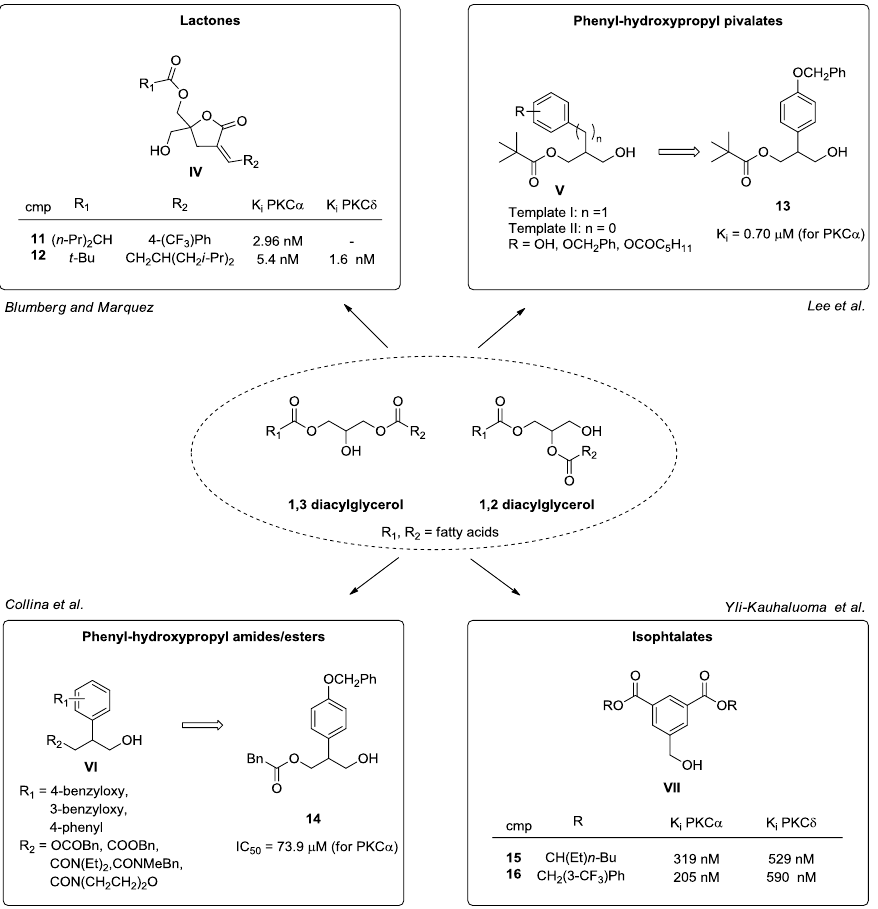
Figure 9. DAG derivatives.